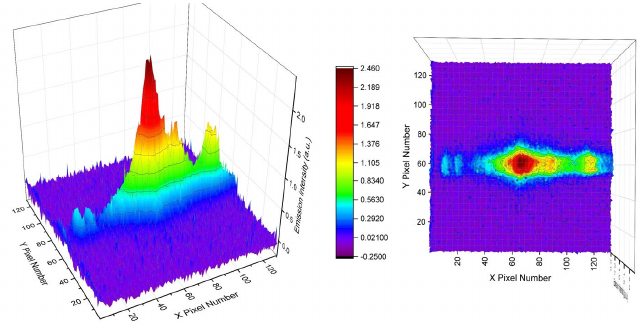
Figure 11. Single-shot LWIR LIBS emissions from KCl samples using the current collection optics setup and the PhaseTech 2 − D array detector. Similar to the calibration processes used on the linear array detector in current and previous studies [1–4], we performed pixel-by-pixel nonuniformity correction using the single-shot LWIR LIBS signal of a pixel and the corresponding blackbody signal of the corresponding pixel. All five distinctive atomic signature bands, 6P 1/2 → 4D 3/2 , 6P 1/2 → 6S 1/2 , 6H → 5G, 7S 1/2 → 6P 3/2 , and 5D 5/2 → 6P 3/2 , of the K atom could be identified in the spectrum. For wavelength calibration, the dispersion function of this 2-D detector setup was formu- lated by using the center wavelengths of these five bands as wavelength markers. The nonuniformity- and wavelength-corrected 2-D LWIR LIBS spectrum of KCl is shown in Figure 12.